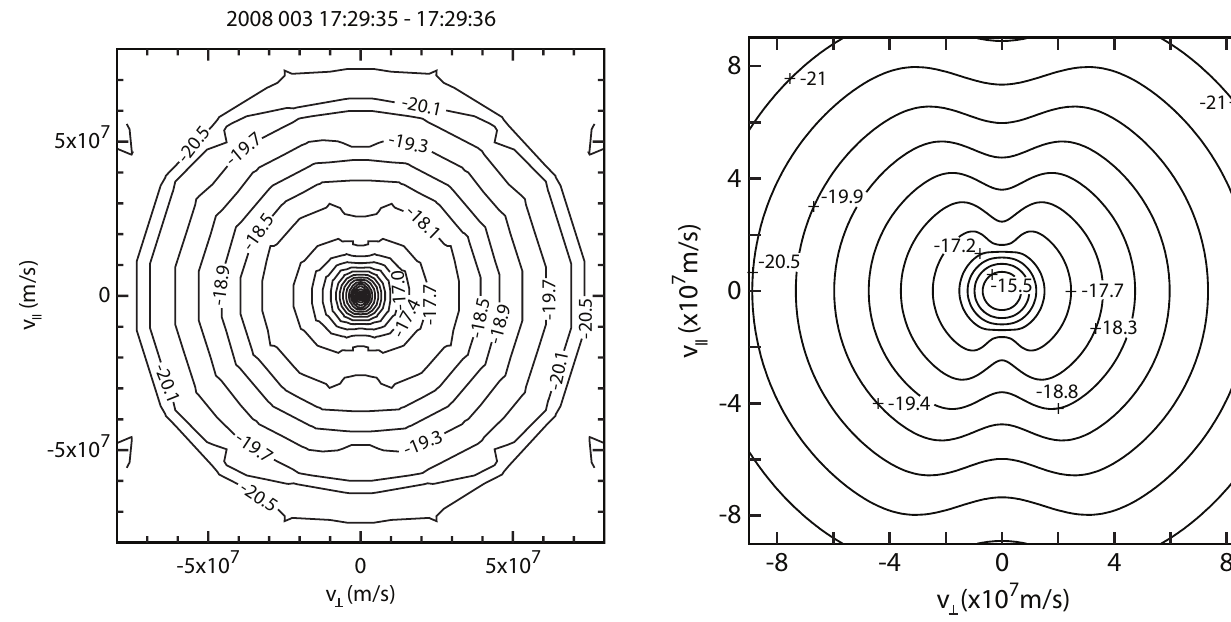
Fig. 4. Contour of the electron phase space density (PSD) for the time interval 17:29:35 to 17:29:36 for E < 20keV, assuming the reflection of the data as described in the text. A loss cone for pitch angles less than about 20 degrees is observed. The contour levels are log 10 (PSD) in units of s 3 /m 6 .